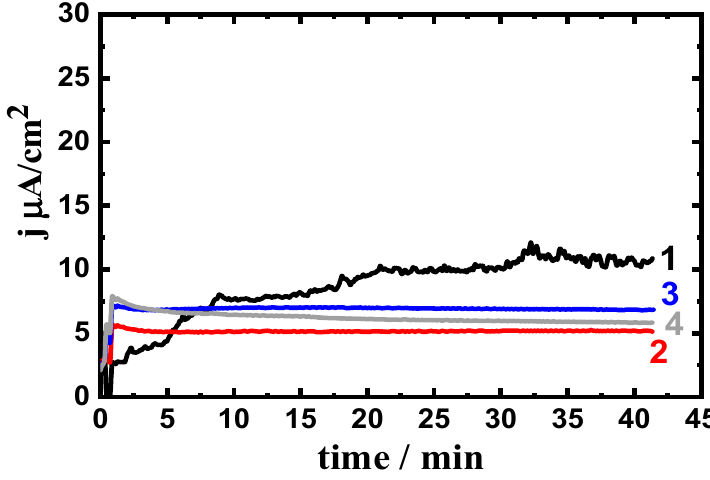
Figure 10. Current–time curves collected at 0.30 V (Ag / AgCl) for (1) Ti6Al2V, (2) Ti6Al4V, (3) Ti6Al6V, and (4) Ti6Al8V alloys after 48 h immersion in 3.5% NaCl solution, respectively.